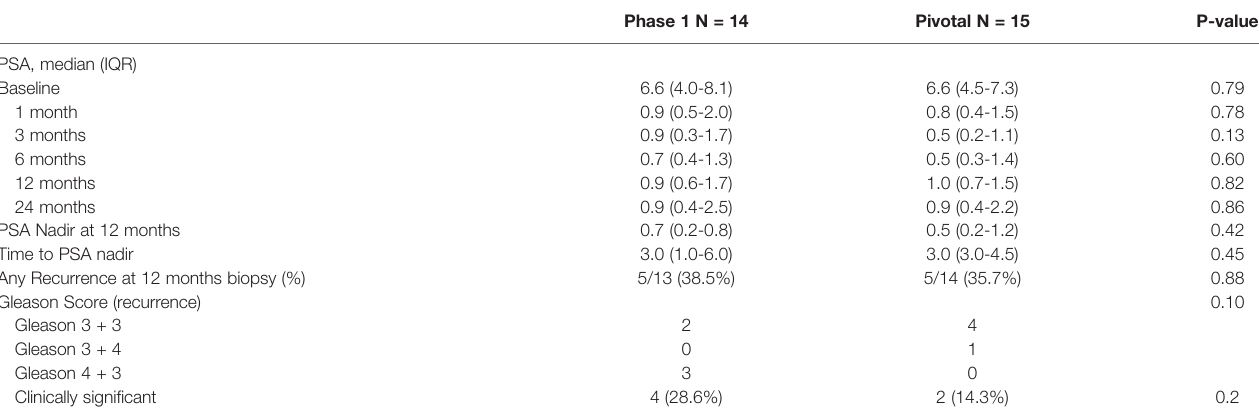
TABLE 2 | Oncological follow-up: PSA values at baseline and follow-up, PSA nadir, time to PSA nadir and results of 12 months prostate biopsy for phase 1 and pivotal trial